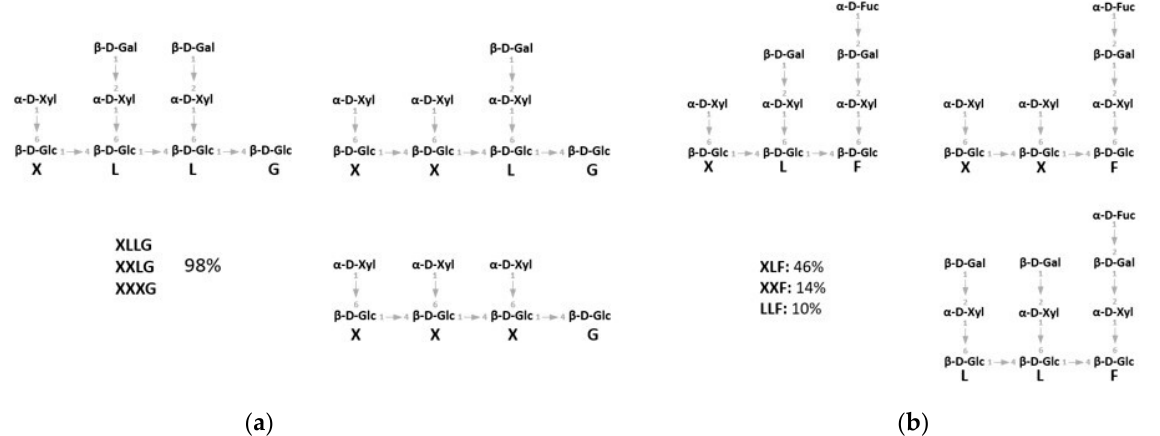
Figure 1. ( a ) Schematic structure of xyloglucan (XG) oligosaccharides (XGOs) from tamarind seeds consisting of a mix of XGOs (XLLG, XXLG, XXXG). ( b ) Schematic structure of XGOs from apple pomace consisting of a mix of XGOs with structure XLF, XXF, LLF (see text for the nomenclature).